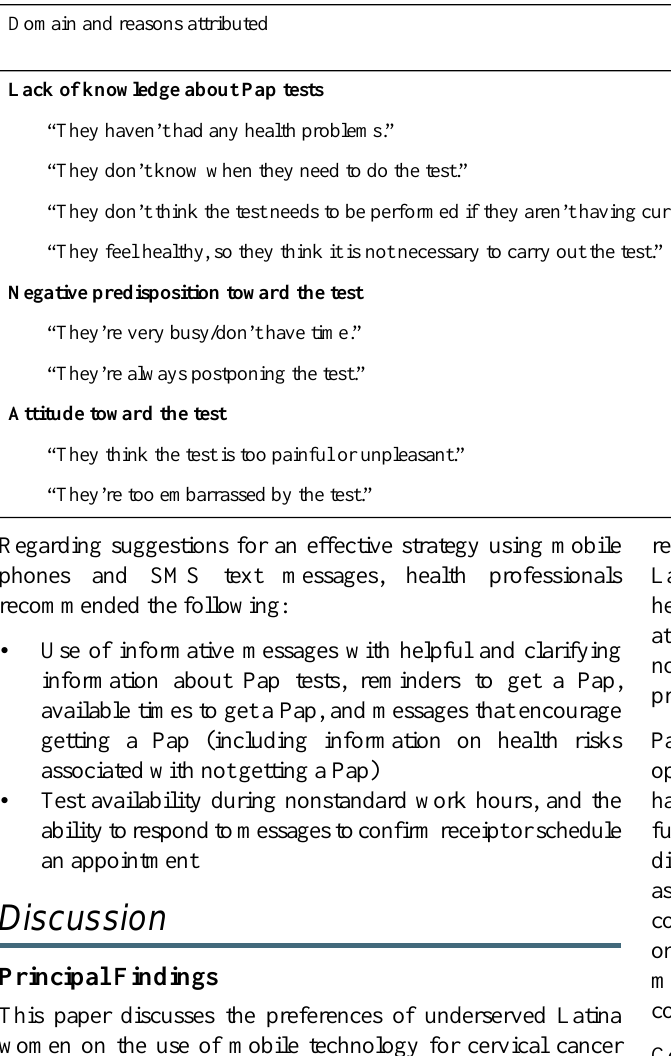
Table 3. Reasons for nonadherence to Pap testing according to health professionals